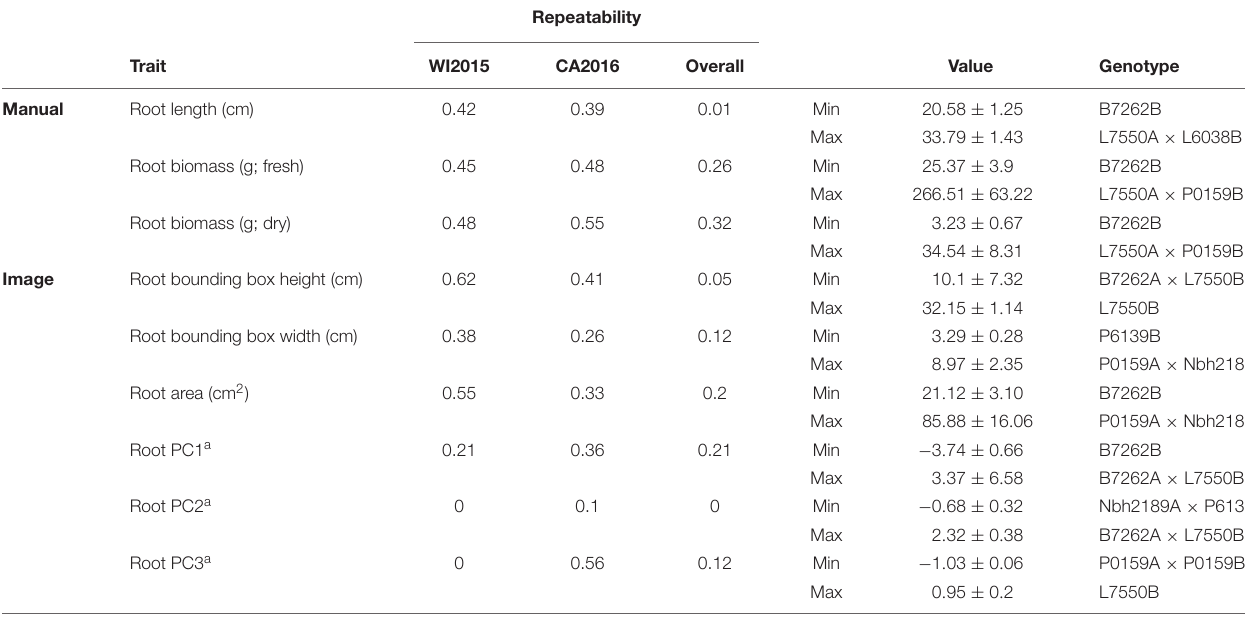
TABLE 2 | Estimates of repeatability, trait ranges, and corresponding pedigrees for root characteristics in 42 inbreds and hybrids from a six-parent carrot